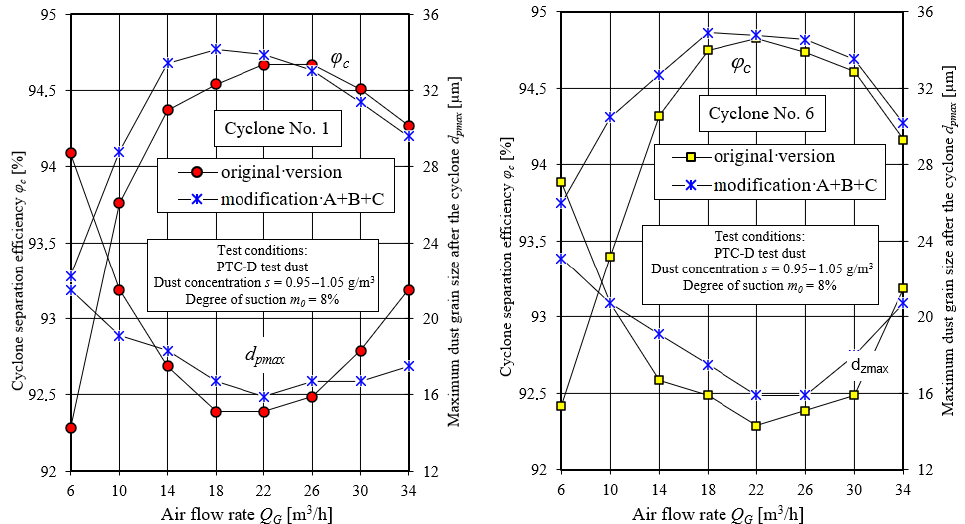
Figure 37. Variation of separation efficiency ϕ c = f ( Q G ) and maximum dust grain size values d pmax = f ( Q G ) in the Q G exhaust air stream of cyclone No. 1 and No. 6 in the original version and after design modification — version III.